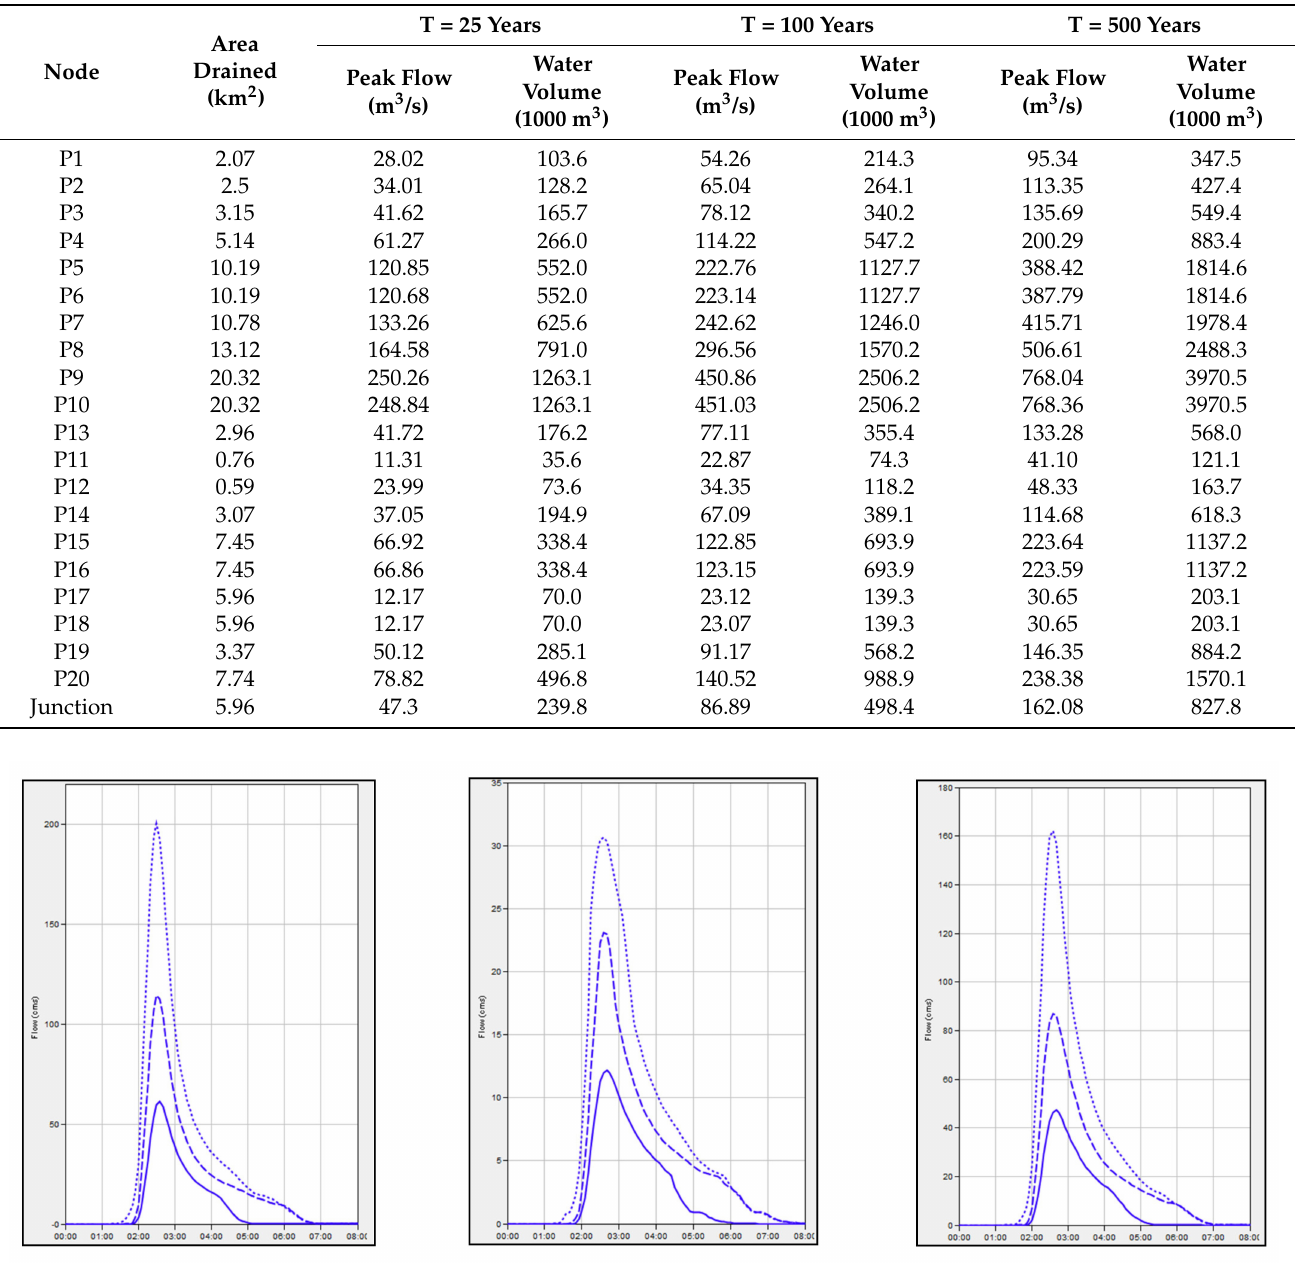
Table 5. Hydrological model results.